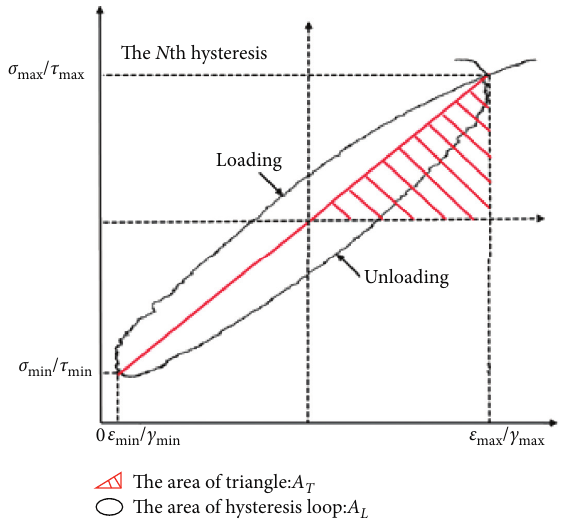
Figure 6: The determination method of the resilient modulus and damping ratio of frozen clay.